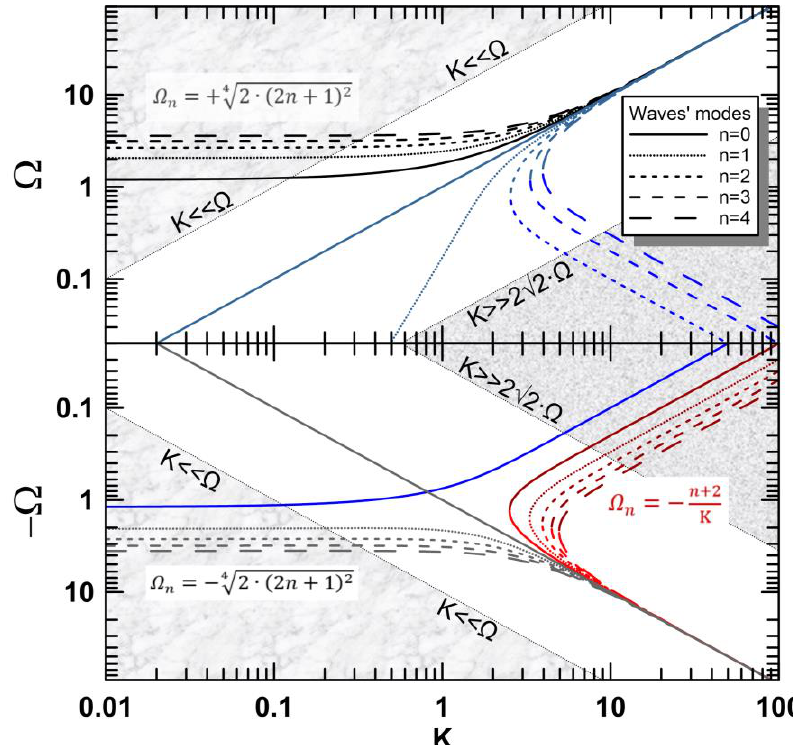
Figure 3. Reduced frequencies (Ω) as a function of the reduced wavenumber (K) and wave modes n displayed in logarithmic scale. The six real roots from the sextic Equation (27) are shown with the same colors as in Figure 2. The wave modes are exhibited with distinct line styles. The shadowed areas represent where the asymptotic conditions are met 𝛫 𝛺⁄ ≫ 2√2 and 𝛫 𝛺⁄ ≪ 1 . The dispersion solution for these asymptotic cases is shown for three of the roots of the sextic